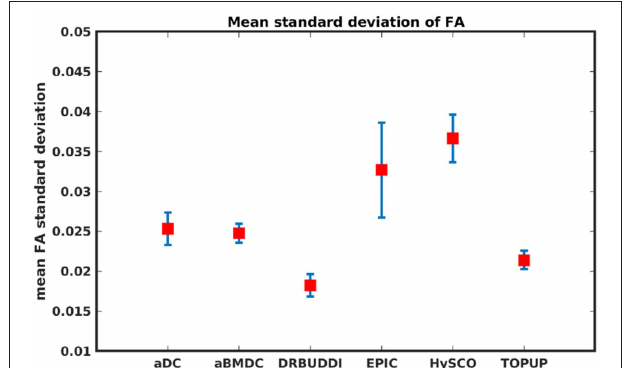
FIGURE 13 | Mean FA standard deviation over LR, RL, AP, and PA data for five simulated HCP subjects using the six methods. The error bars represent standard deviation of this metric across subjects. DR-BUDDI produces the smallest standard deviation.